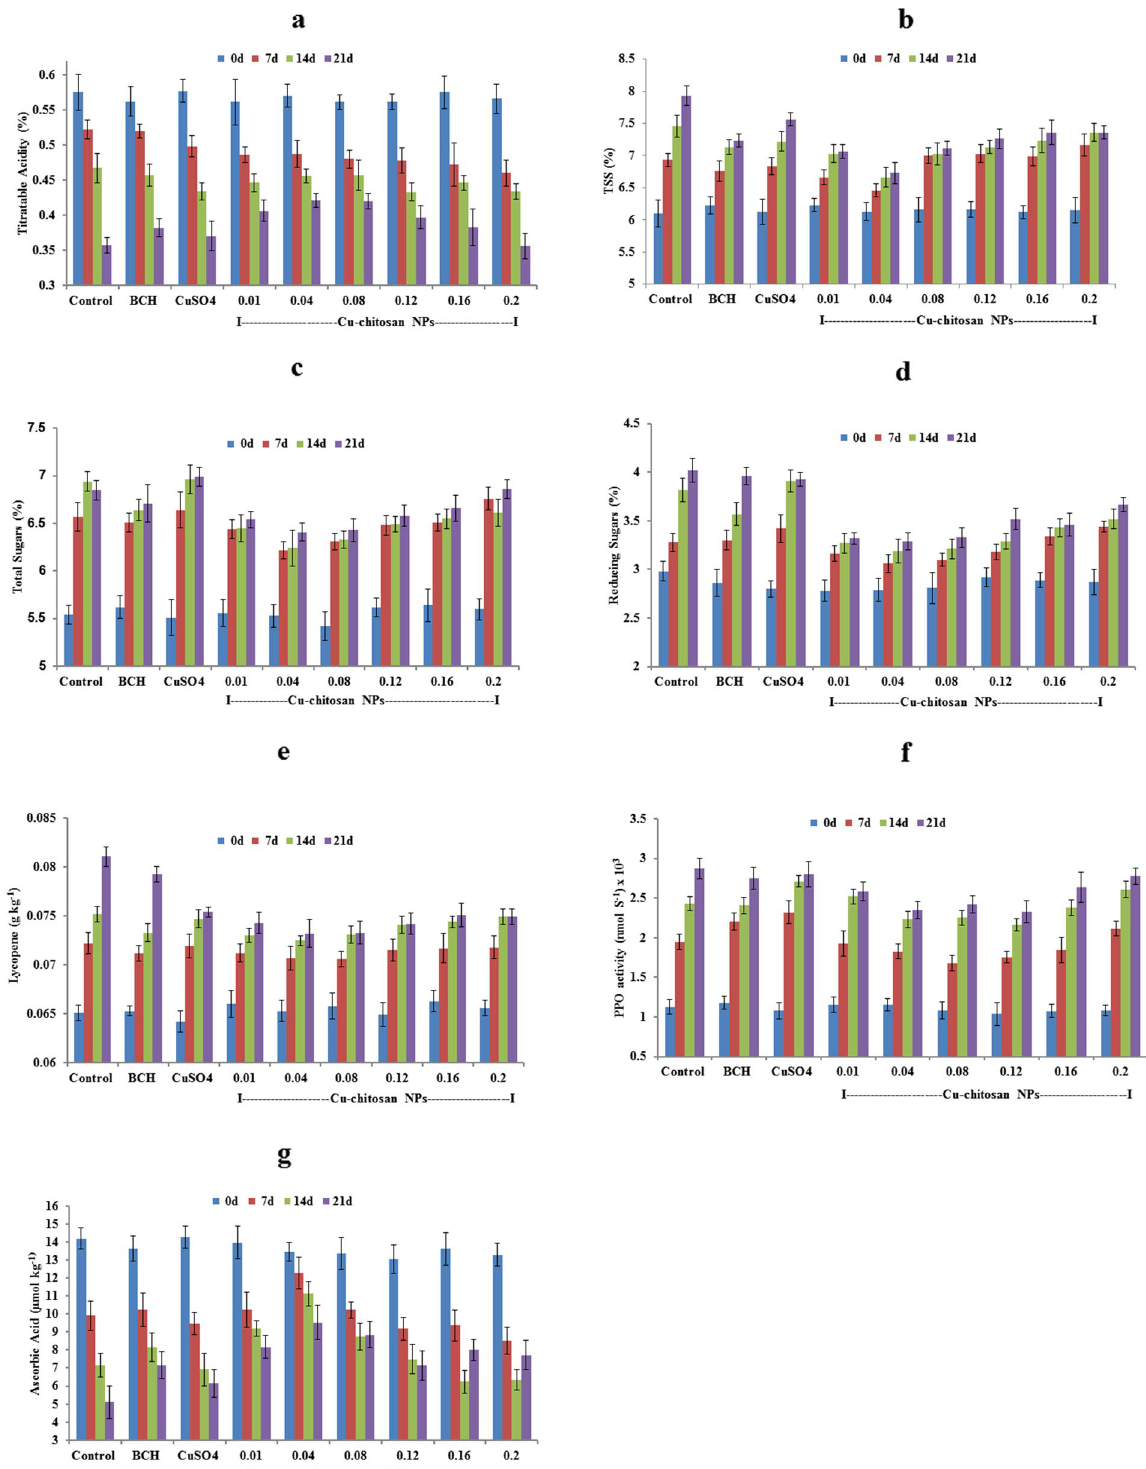
Figure 3. Effect of Cu-chitosan NPs on ( a ) titratable acidity ( b ) total soluble solids and ( c ) total sugar ( d ) reducing sugars ( e ) lycopene ( f ) polyphenol oxidase and ( g ) ascorbic acid in tomato stored at room temperature. Each value is mean of triplicates and each replication consisted of 5 tomatoes. BCH (bulk-chitosan) dissolved in 0.1% acetic acid and CuSO 4 (0.01%) dissolved in water. Error bars represents ± SE (standard